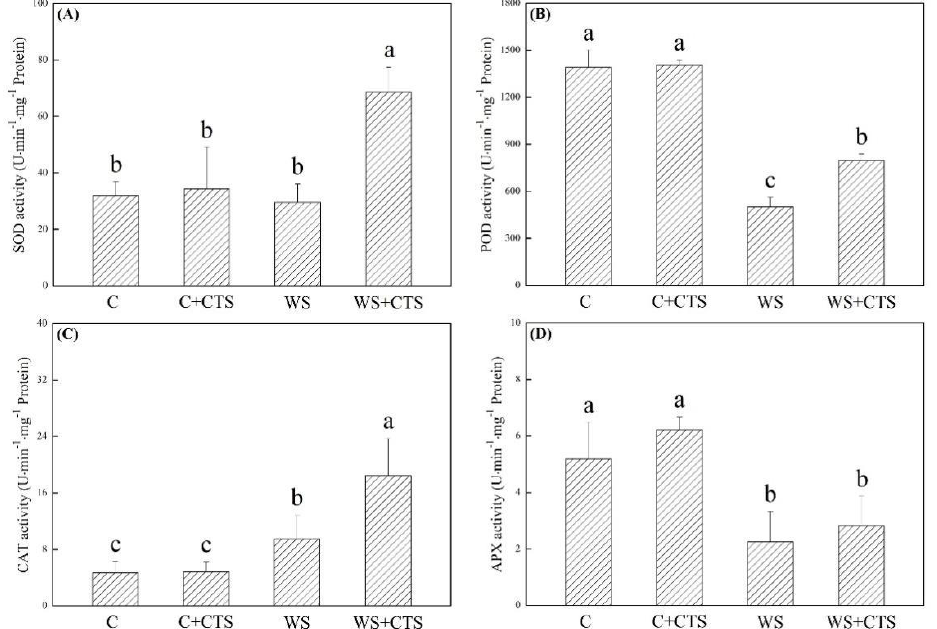
Figure 5. Seeds priming with chitosan affected ( A ) superoxide dismutase (SOD) activity, ( B ) perox-